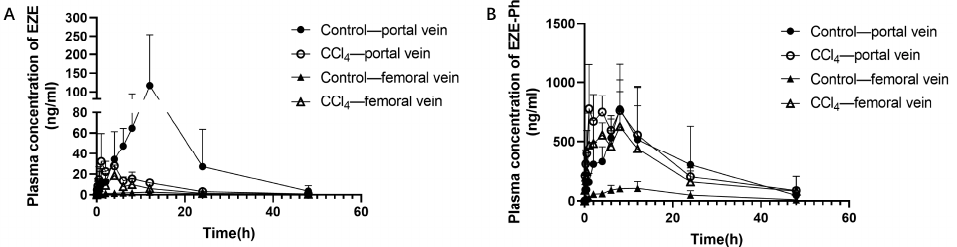
Figure 5. Mean plasma concentration–time profiles of EZE ( A ) and EZE-Ph ( B ) in portal vein and femoral vein blood following oral administration of 10 mg/kg of EZE to control and CCl 4 -induced rats. Each point was presented as mean ± S.D. ( n = 5).